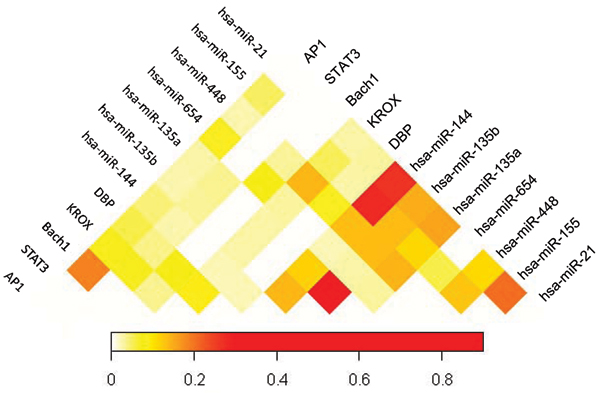
Heatmap of the percentage of target genes that contain co-occurrent transcription factors or microRNAs.